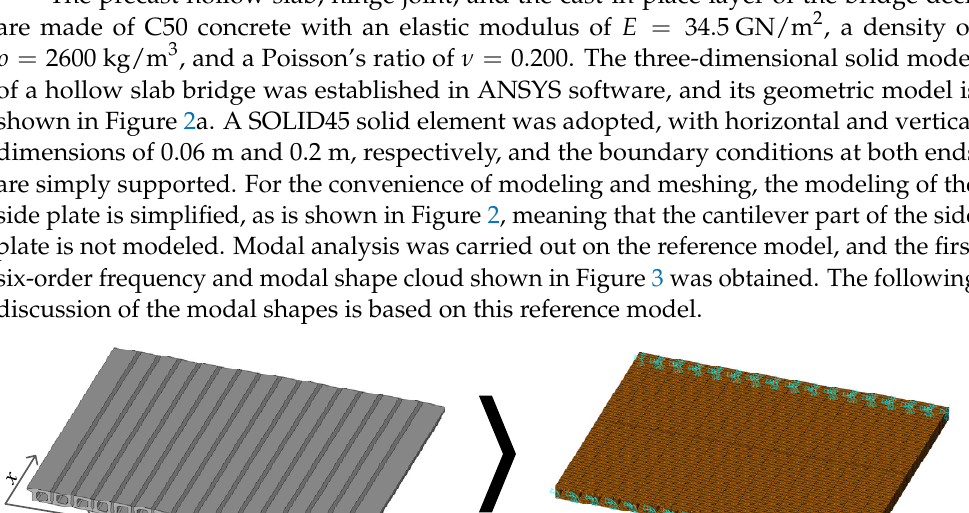
Figure 2. The model of a hollow sab bridge: ( a ) geometric model; ( b ) finite element model.